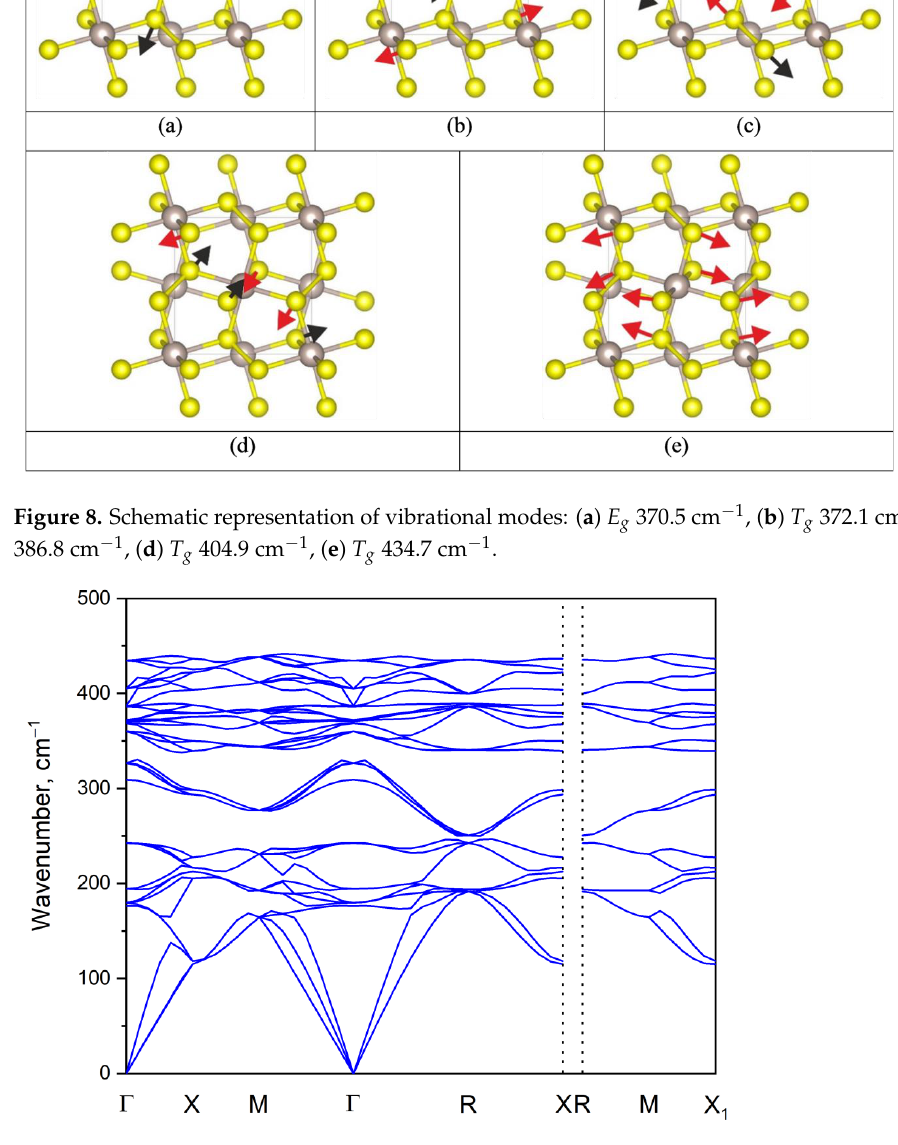
Figure 10. Experimental (blue spectrum) Raman spectrum of the sample (Rh,Ir,Ru) 3 S 8 and calculated dashed spectral diagrams of Ru 3 S 8 (black), Rh 3 S 8 (red), and Ir 3 S 8 (orange).